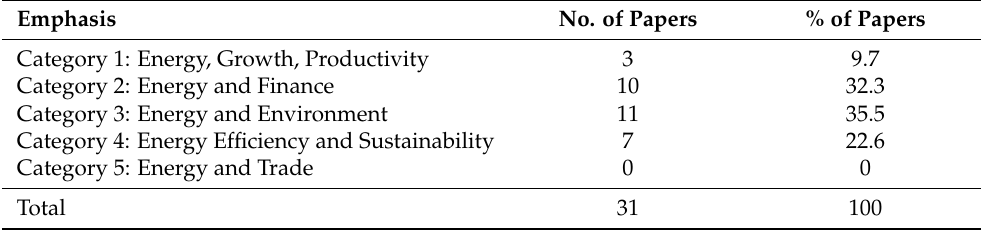
Table 2. Number of papers by area of emphasis—Most Influential Papers.